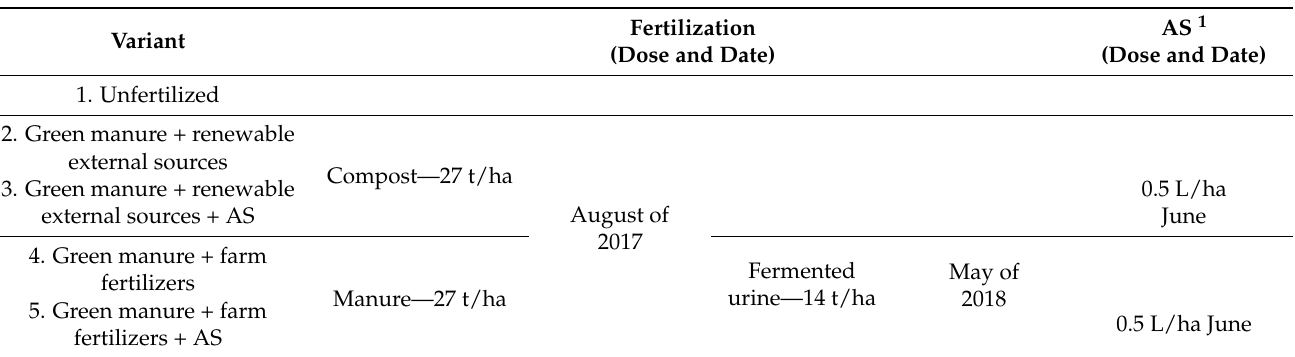
Table 5. Fertilization of legume-cereal mix and silage corn